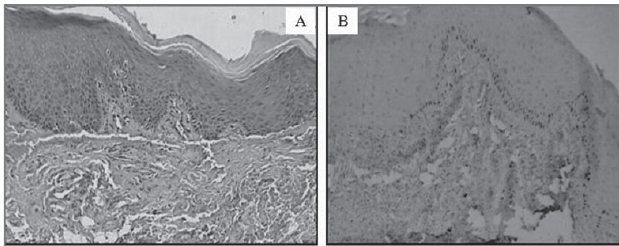
Fig. 2 H/E (A) and IHC staining with p53 expression (B) showing mild dysplasia (10x).